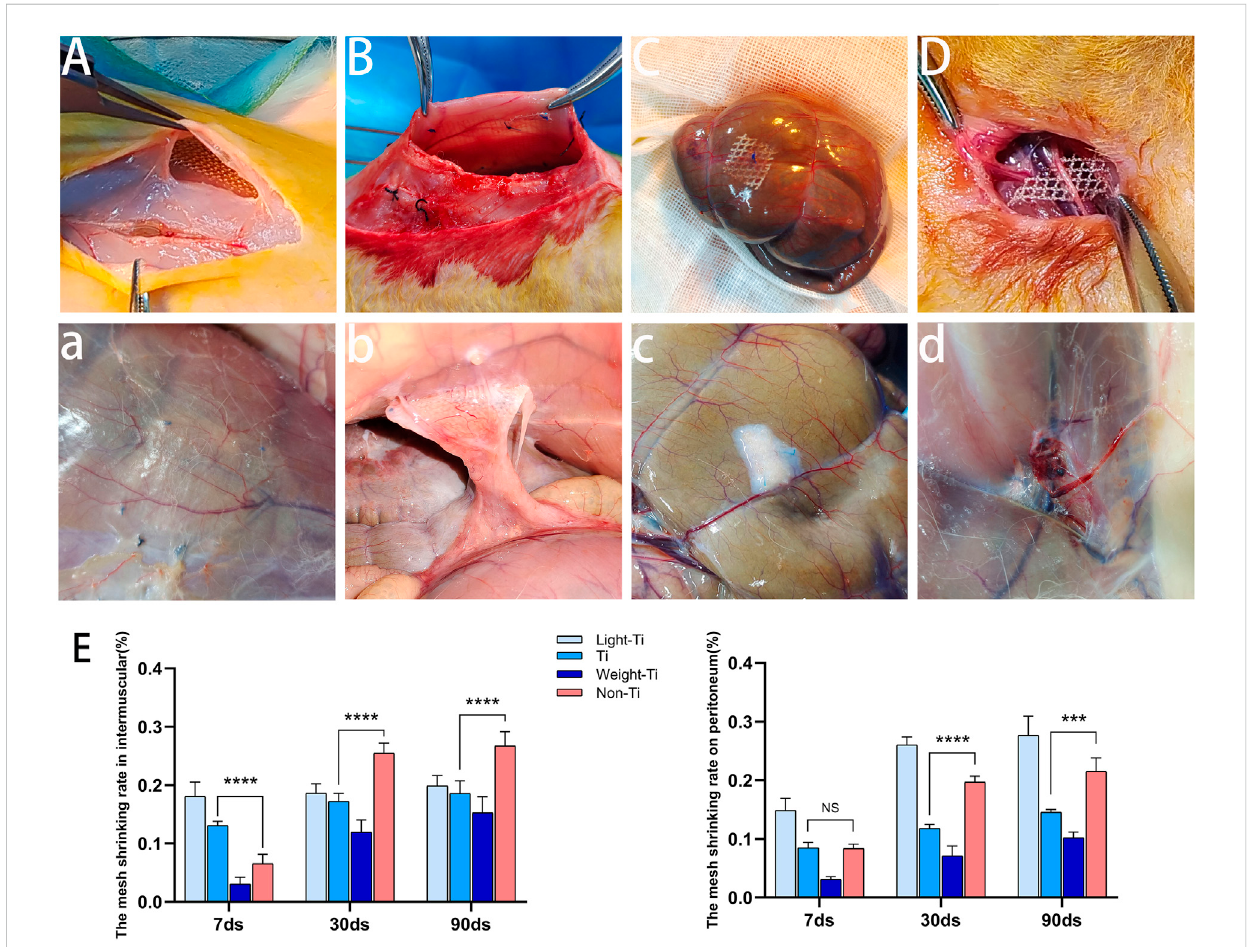
The conditions of meshes during operation and dissection and the shrinkage rate of meshes. (A) The mesh placed between the external oblique abdominal muscle and the internal oblique abdominal muscle during operation; (A) The mesh placed between the abdominal muscles at dissection; (B) Themeshplacedontheparietalperitoneumduringoperation; (B) Themeshplaced ontheparietalperitoneumatdissection; (C) Themeshplacedonthe wall of the descending colon during operation; (C) The mesh placed on the wall of the descending colon at dissection; (D) The mesh placed under the femoral nerve during operation; (D) The mesh placed under the femoral nerve at dissection; (E) the shrinkage rate of meshes placed between the external oblique abdominal muscle and the internal oblique abdominal muscle and on the parietal